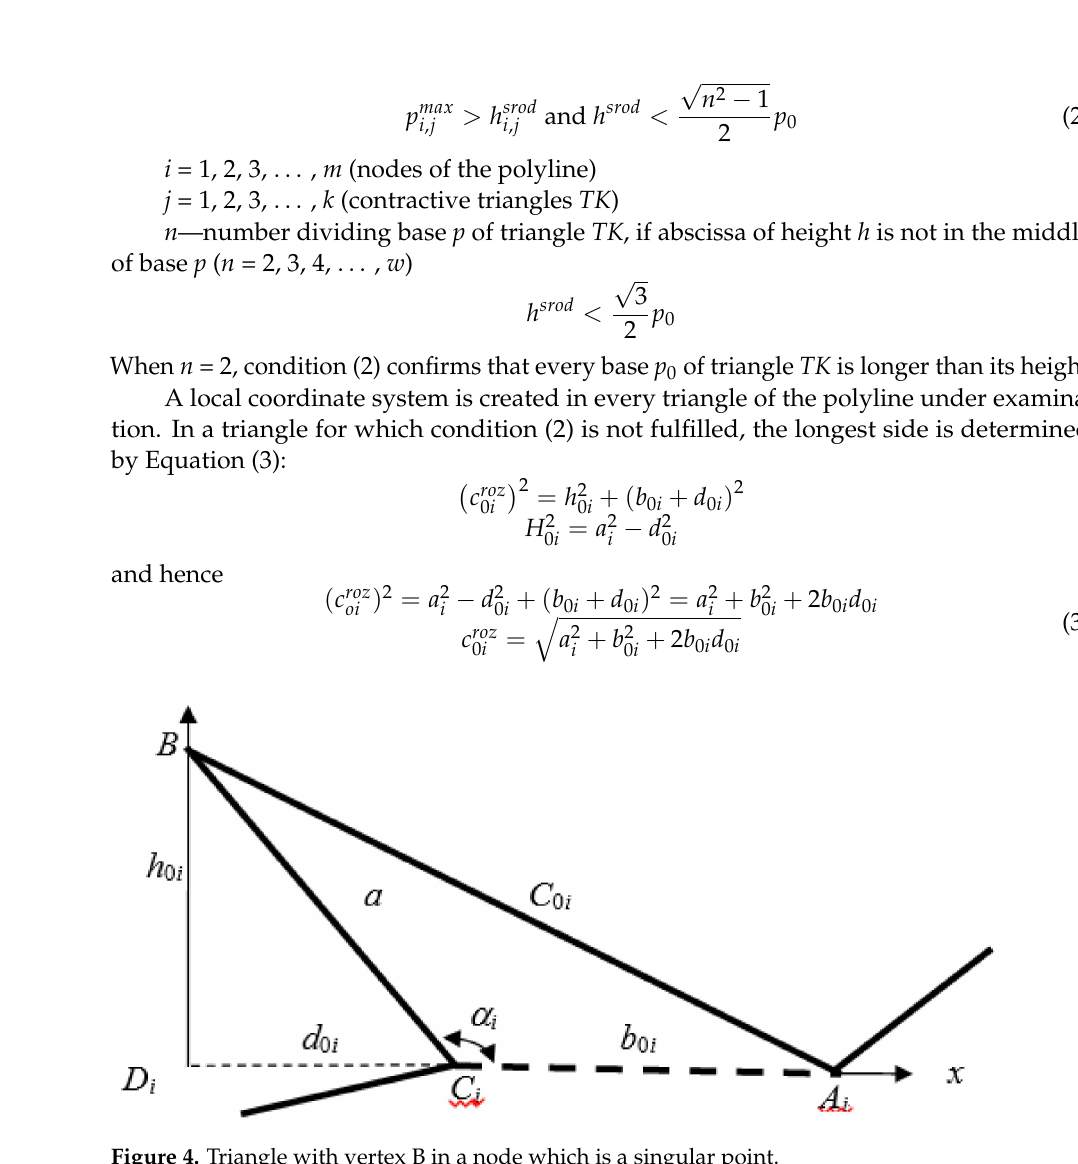
Figure 4. Triangle with vertex B in a node which is a singular